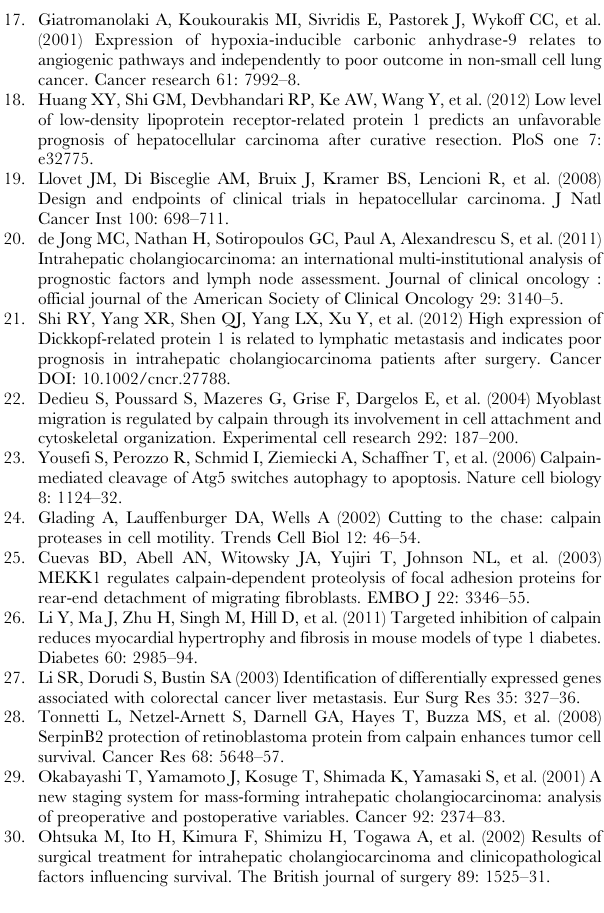
Figure S4 The percentage of Capn4-positive staining in ICC tissues was greater than in peritumor and normal liver tissues; the difference was statistically significant (p , 0.01). Figure S5 The patients from the TMA consisting of 138 ICC tissues with high Capn4 expression had a poorer prognosis in terms of overall survival and cumulative recurrence. Figure S6 There is no difference in the expression of talin, paxillin, and FAK protein between HCCC-9810-si-